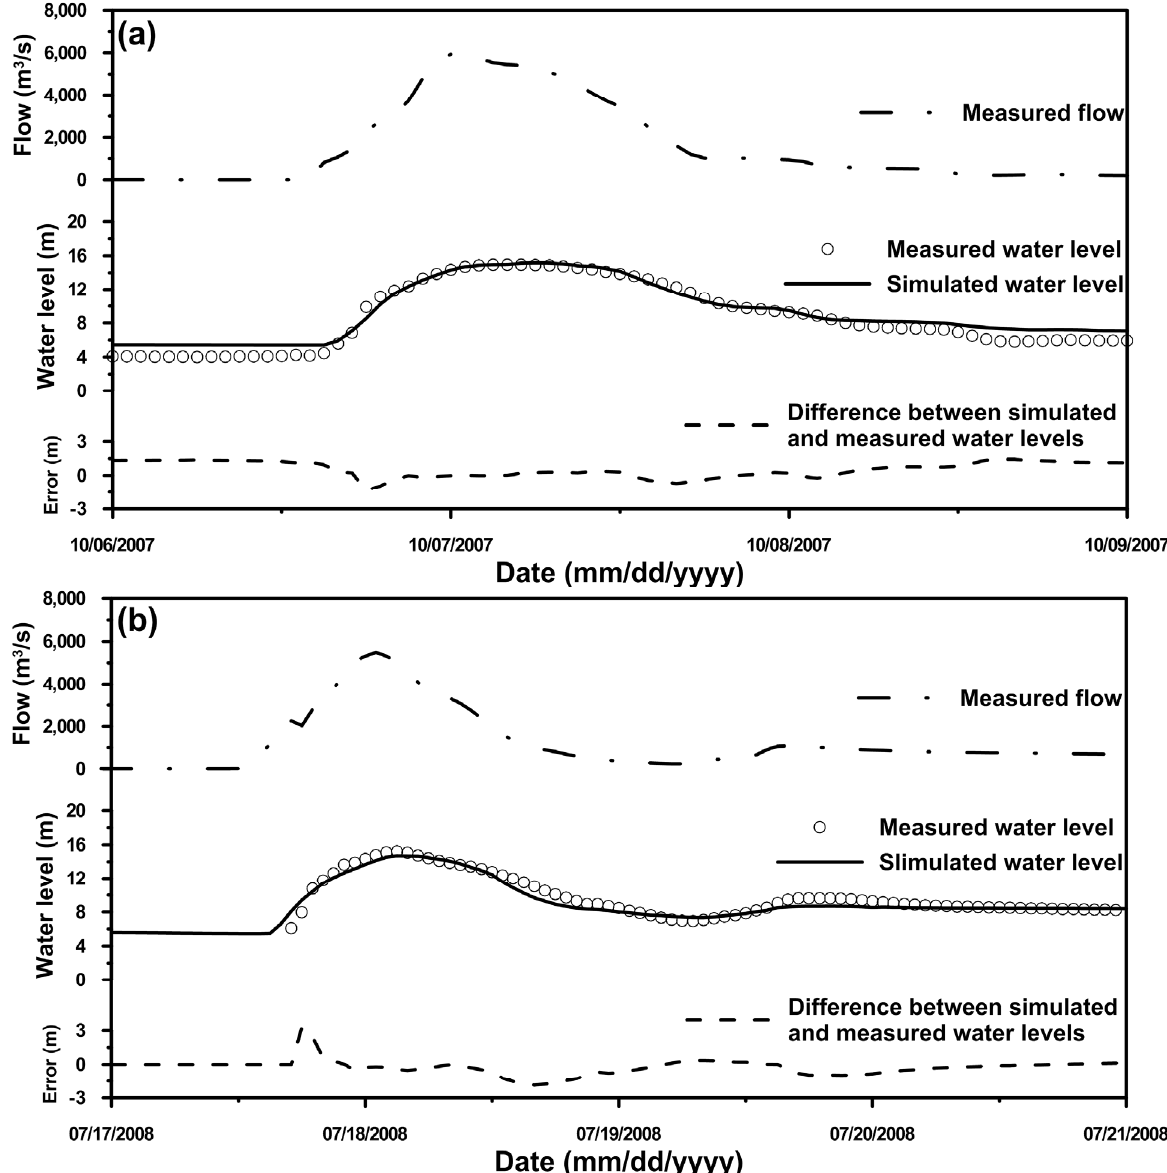
Figure 6. Comparison of model predictions of water level with observation results at the Tsengwen Bridge for ( a ) Typhoon Krosa (2007); ( b ) Typhoon Kalmaegi (2008); and ( c ) Typhoon Morakot (2009). The flow represents the measured freshwater discharge at the upstream boundary (Erxi